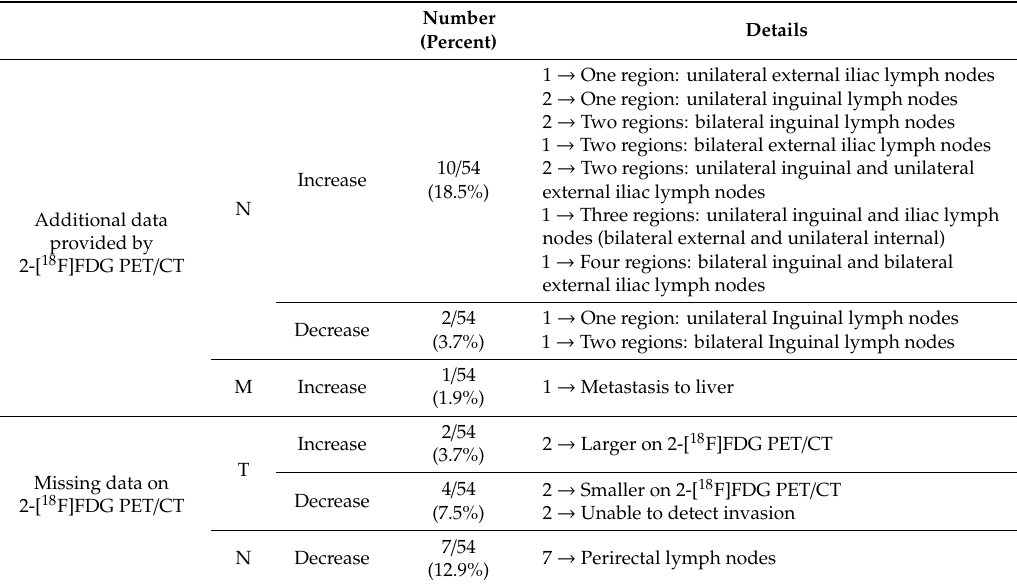
Table 4. Discordant findings regarding TNM.